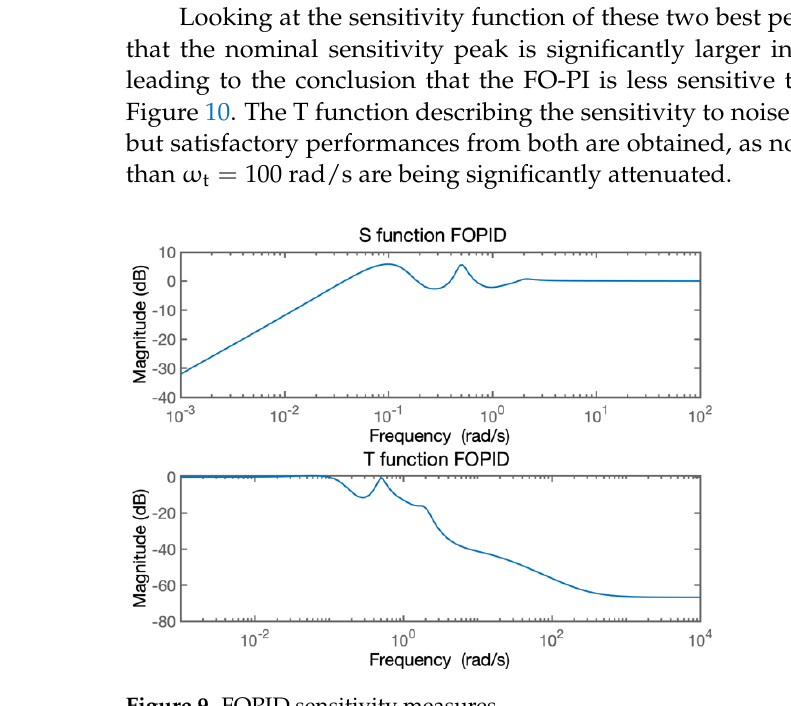
Figure 9. FOPID sensitivity measures.